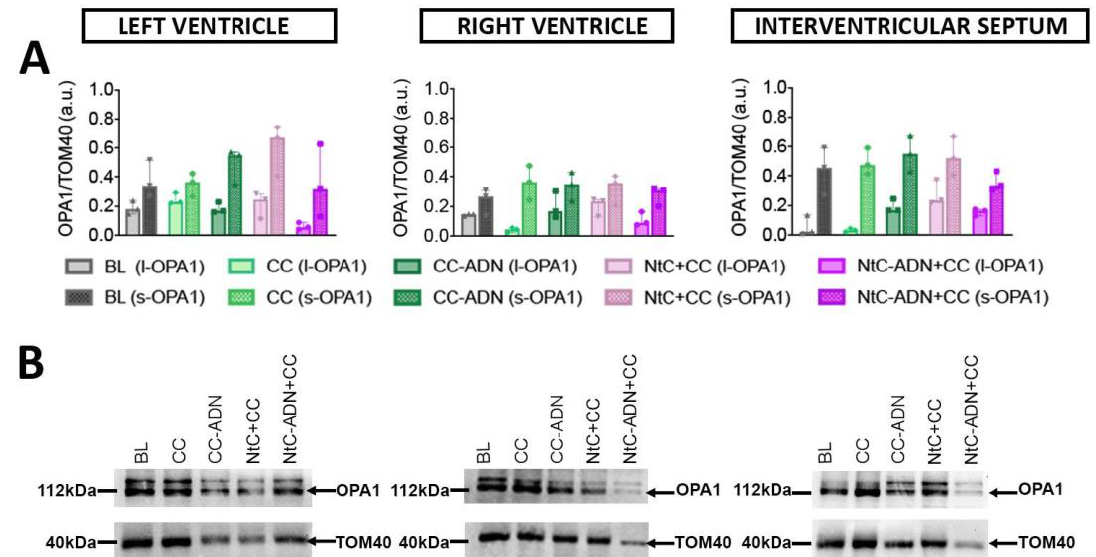
Figure 4. Detection of OPA1 in heart tissue. Quantitative results ( A ) and representative Western blots ( B ) of OPA1 of different heart regions treated with different cardioplegia solutions. TOM40 was used as loading control. Values are shown as median ± range, n = 3. BL: baseline; CC: cardioplegia; CC-ADN: cardioplegia supplemented with adenosine; NtC + CC: 250 mL warm cardioplegia + 750 mL cold cardioplegia; NtC-ADN + CC: 250 mL warm cardioplegia supplemented with aden- osine + 750 mL cold cardioplegia.